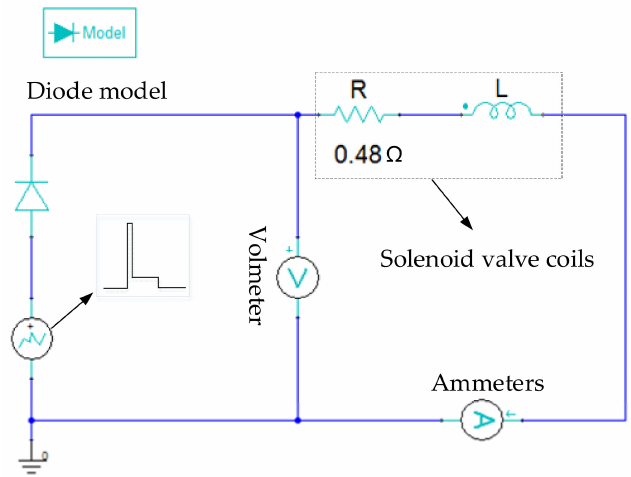
Figure 8. The coil excitation adopts the external